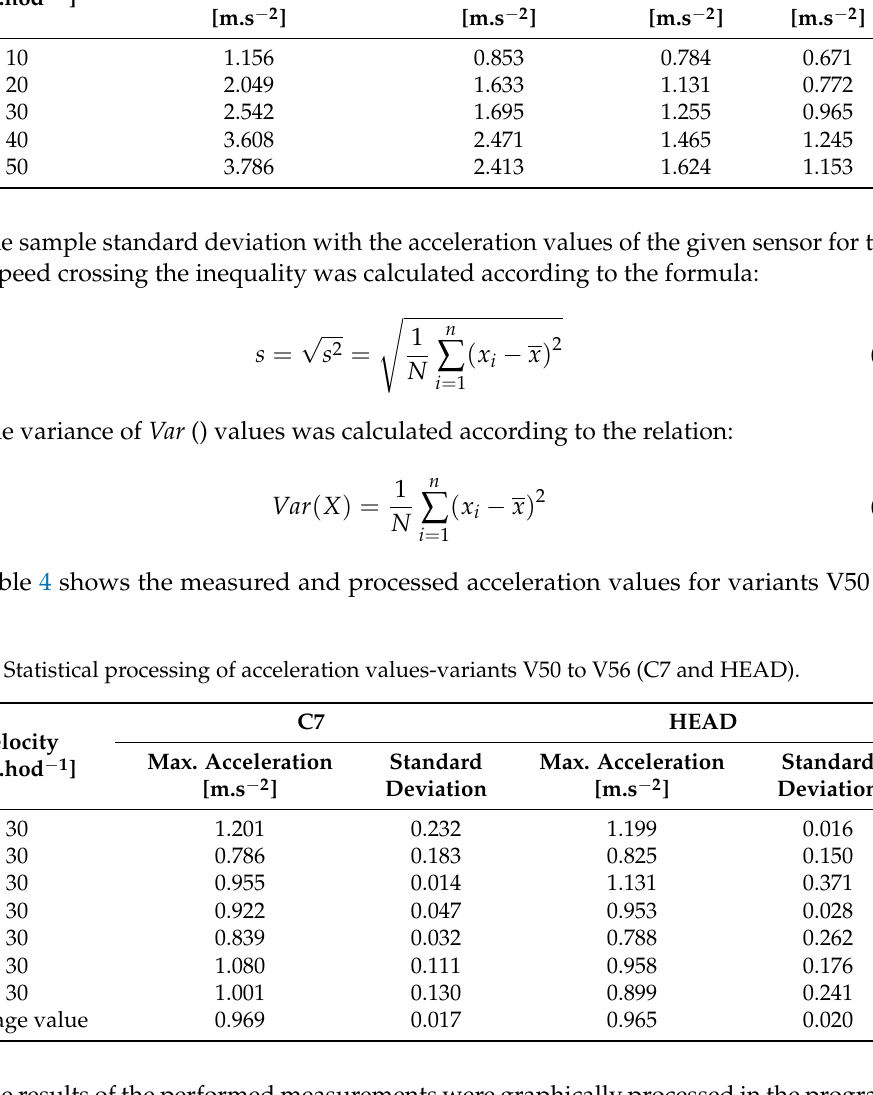
Table 3. Average values of accelerations for co-driver-variants V36 to V70. Velocity